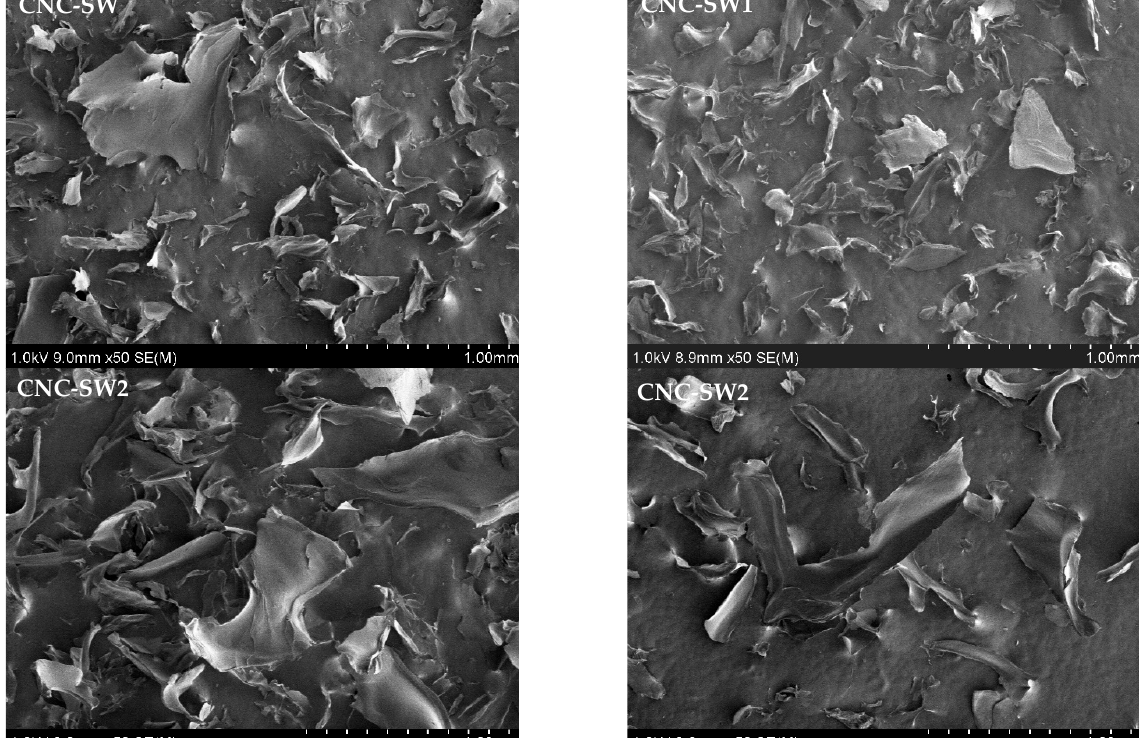
Figure 14. SEM images of CNC from SW and oxidized SW.